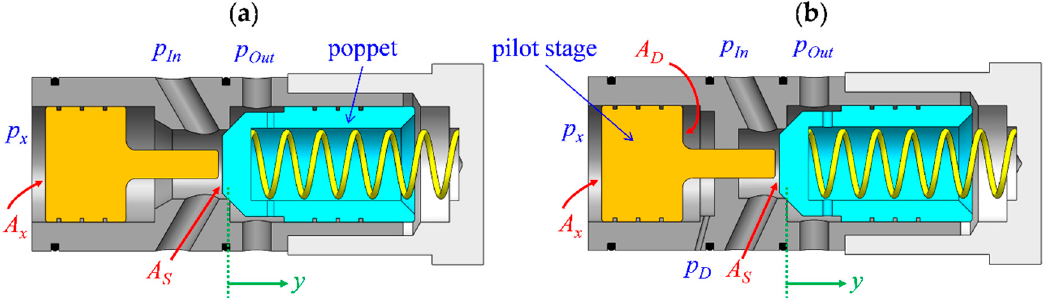
Cross-sectional views of pilot-operated check valves: ( a ) Non-vented design; ( b ) Vented design. If a POCV comes in the vented version, the previous definition of the operating modes holds true, but the criterion for “normal flow” becomes p x · A x < p D · A D + p In · ( A x – A D ). The force balance for the “normal flow” condition is still given by Equation (16), whereas it is described in Equation (18) for the other operating mode. The pilot stage’s area inside the drain chamber ( A D,i ) and the drain pressure ( p D,i ) are included.